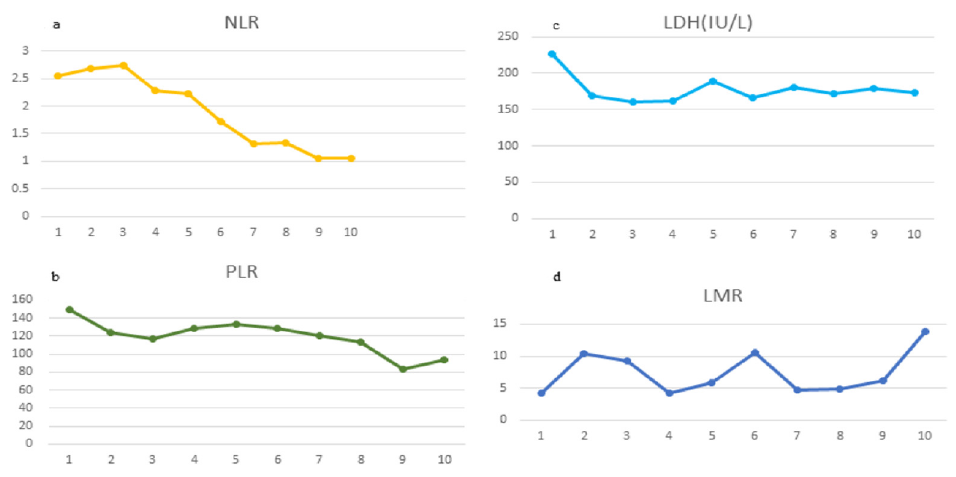
Figure 2. ( a ) indicates the decreasing trend of the NLR; ( b ) indicates a decrease in the PLR; ( c ) indicates a higher level of serum LDH at the time of initial diagnosis, which decreased after treatment; ( d ) indicates a significant fluctuation in the